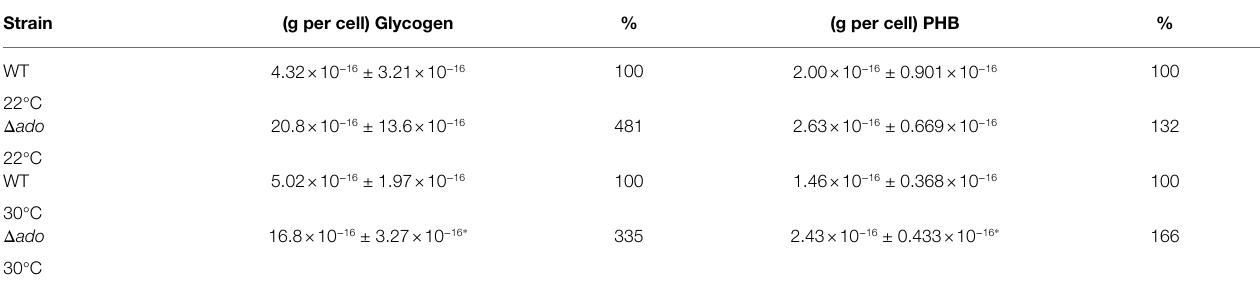
TABLE 2 | Quantification of storage compounds glycogen and poly- β -hydroxybutyrate (PHB), per cell from Δ ado and WT Synechocystis sp. PCC 6803 cultures grown for 4 days at 22 ° C and 30 ° C. Strain (g per cell) Glycogen